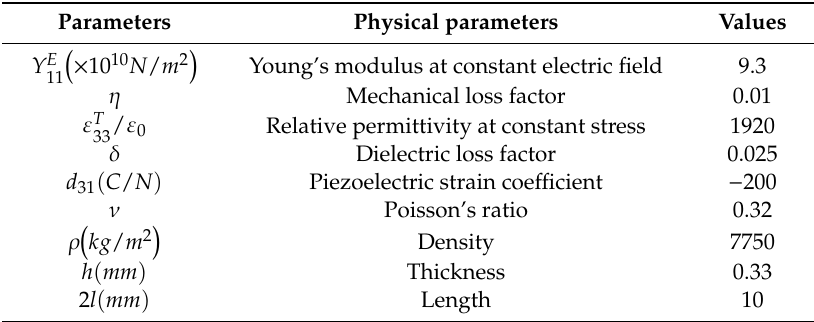
Table 2. Key parameters of square piezoelectric transducer (PZT)